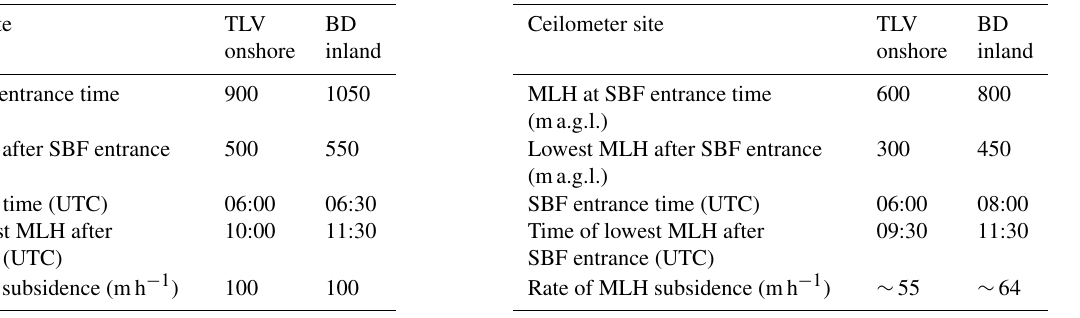
Table 5. Wind ( U , V ) in 925mb at 06:00UTC (09:00LST)